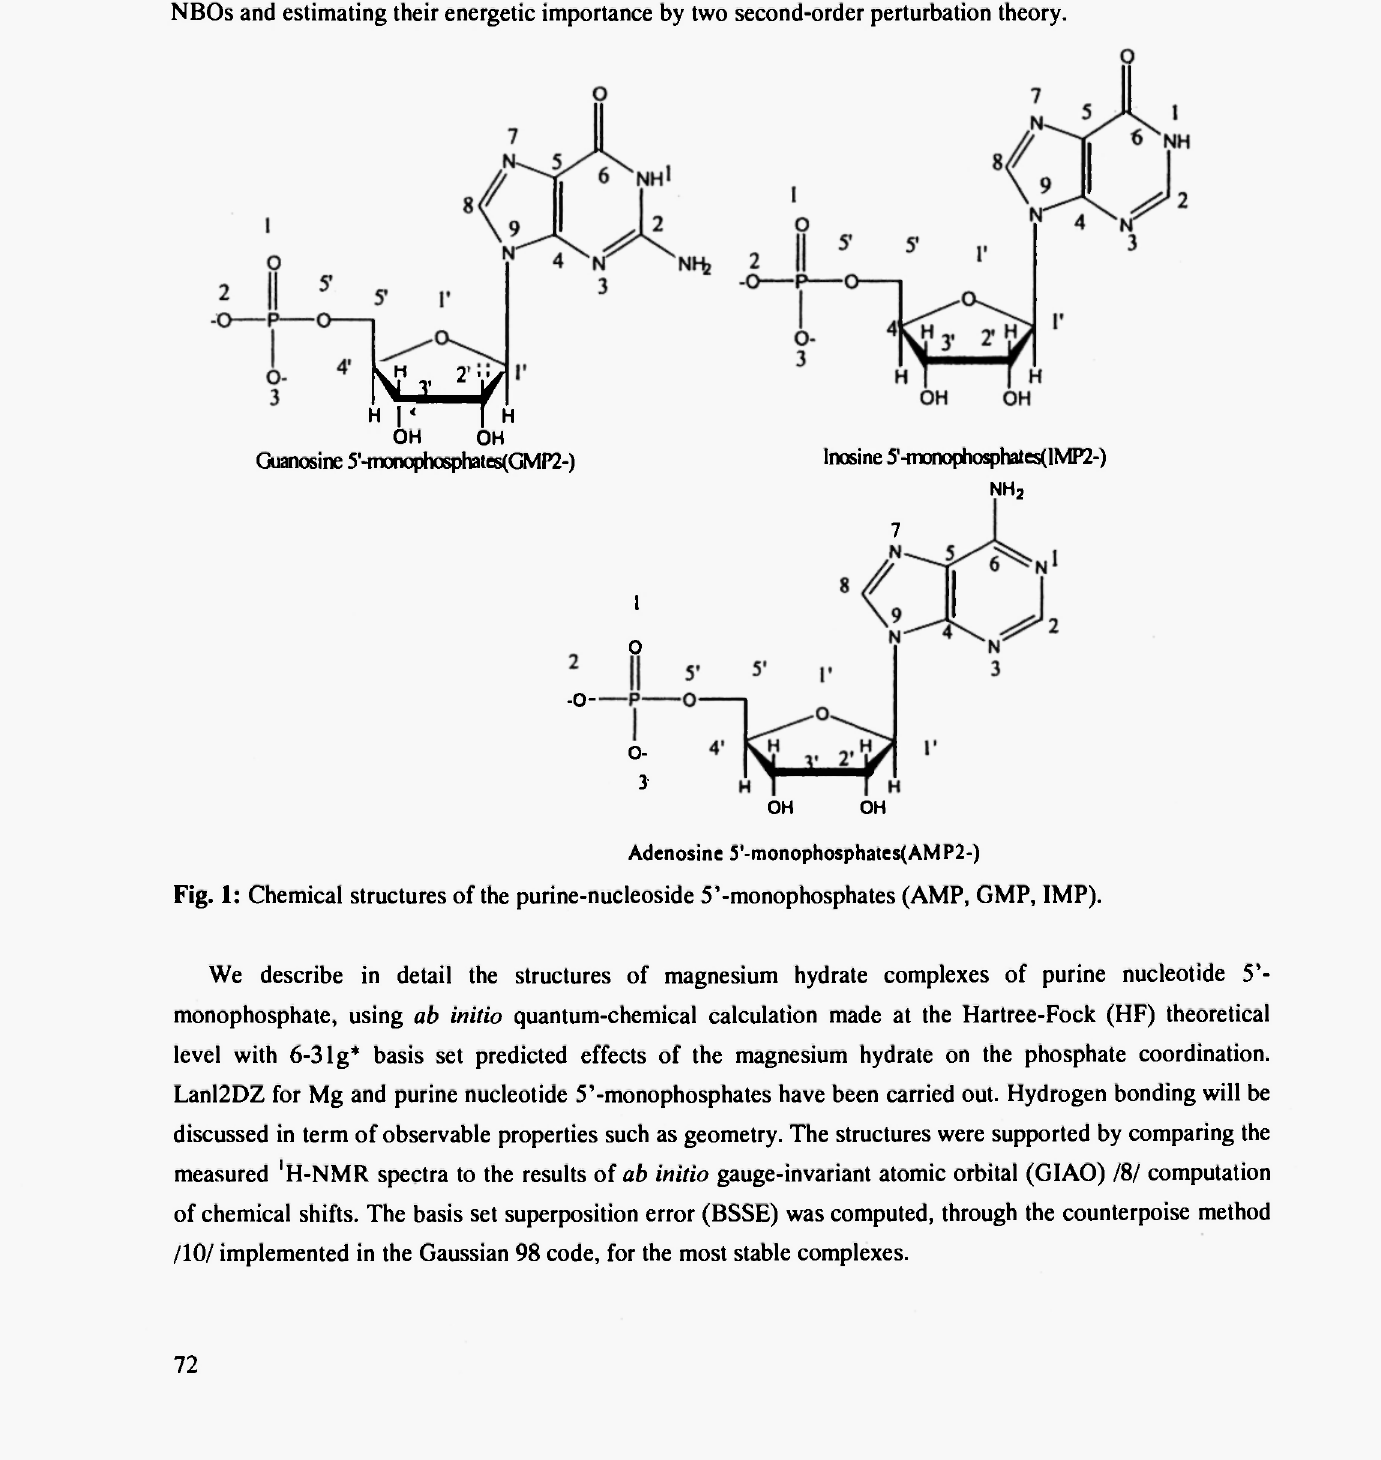
Lanl2DZ for Mg and purine nucleotide 5'-monophosphates have been carried out. Hydrogen bonding will